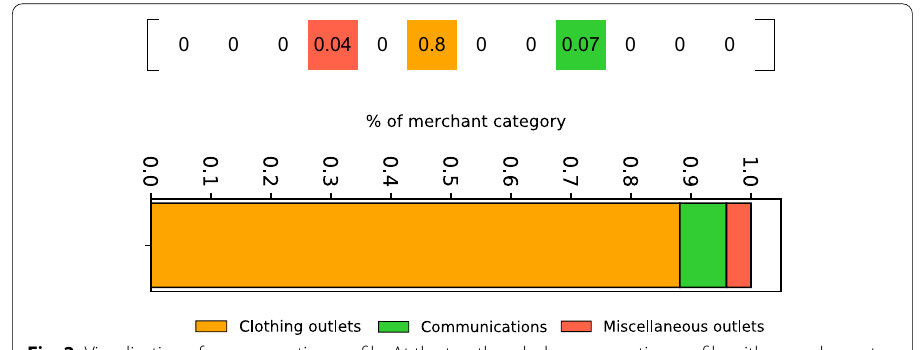
Fig. 2 Visualization of a consumption profile. At the top the whole consumption profile with zero-elements. Then, the vector is displayed as an horizontal stacked barplot where each color segment corresponds to a specific merchant category and its width is proportional to the value in the consumption profile